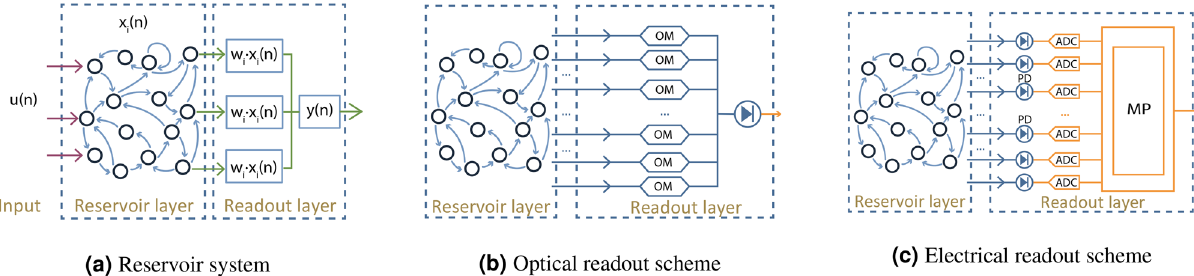
Figure 1. ( a ) Reservoir computing consists of a reservoir layer, which is inherently an untrained RNN, and a readout layer that weights and linearly combines of output channels of the reservoir. ( b ) An integrated optical readout takes advantage of standard optical modulators (OM) to weigh the optical signals from the reservoir in both amplitude and phase with no latency and very low energy cost. The linear combination of the optical signals can be achieved using optical combiners. ( c ) A Conventional integrated electrical readout requires an individual photodetector (PD) and Analog-To-Digital converter (ADC) for each output channel, as well as